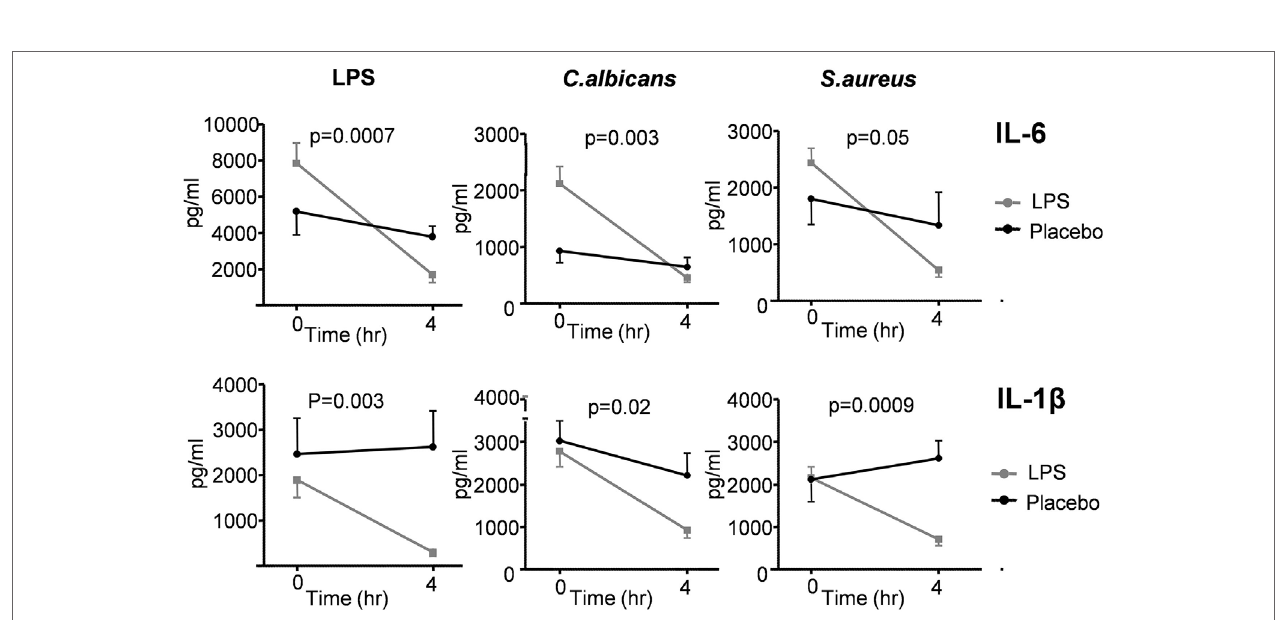
FigUre 7 | Production of IL-6 and IL-1 β measured in supernatants of ex vivo stimulated monocytes of 30 subjects who received lipopolysaccharide (LPS) ( n = 15) or placebo ( n = 15) at T = 0. Monocytes were stimulated with LPS, Candida albicans , and Staphylococcus aureus. Cytokine production was measured at T = 0 (baseline) and 4 h after administration of LPS/placebo. Data are represented as mean ±